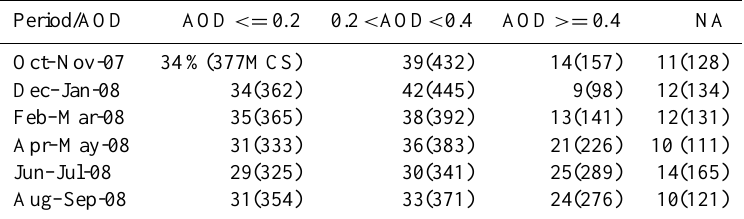
Table 2. Percentage (number) of Mesoscale Convective Systems (MCS) that was tagged with: AOD < = 0 . 2 (column 1), 0.2 < AOD < 0.4 (column 2) and AOD > = 0 . 4 (column 3). The last column shows the percentage of events that could not be tagged. Period/AOD AOD < = 0 .